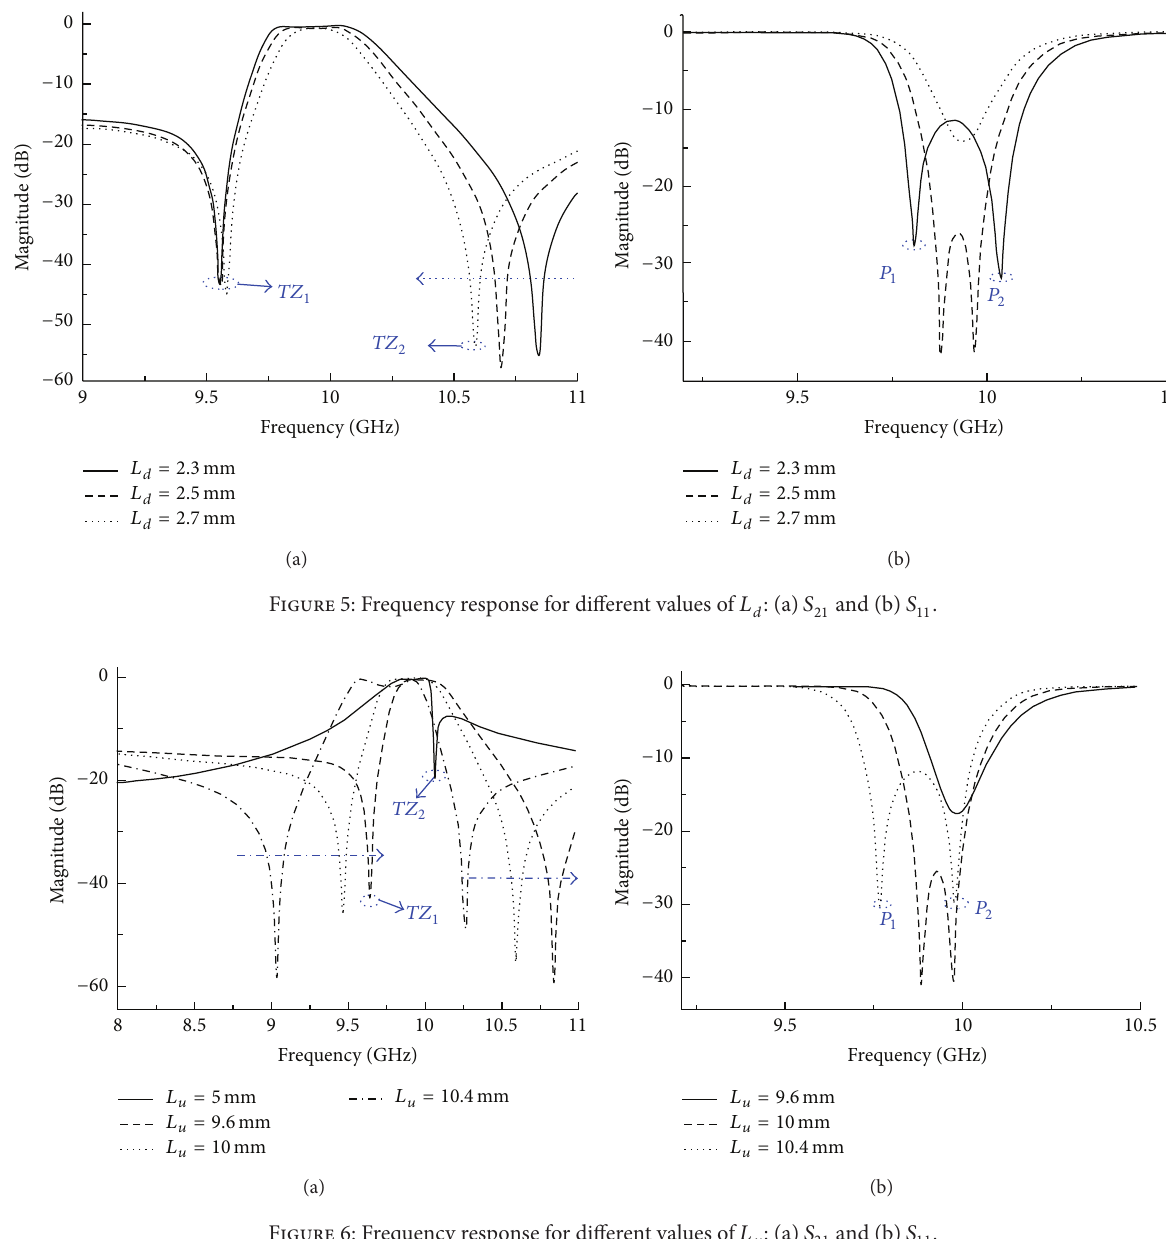
Figure 6: Frequency response for different values of 𝐿 𝑢 : (a) 𝑆 21 and (b) 𝑆 11 .